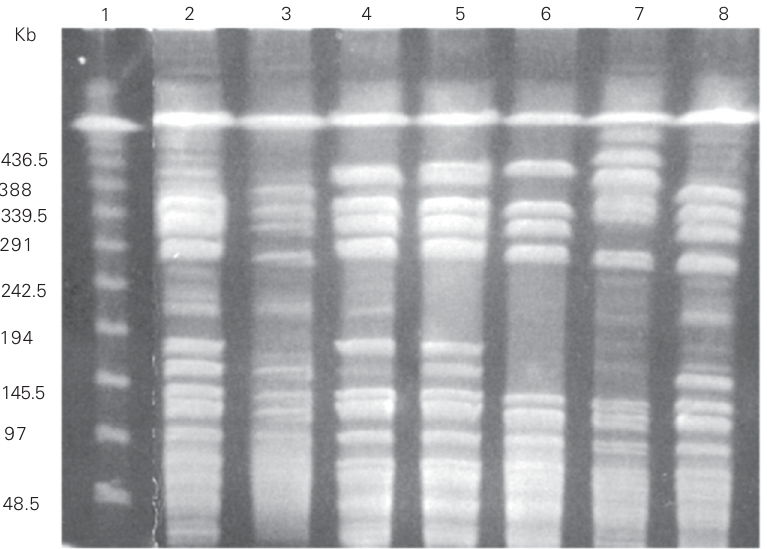
Figure 2. Pulsed-field gel electrophoresis profiles of genomic DNA from methicillin- resistant Staphylococcus aureus (MRSA) strains isolated from patients with hospital infection from May 1995 to August 2001 (period II). Lane 1 : Molecular weight marker ( λ ladder); lanes 3 , 4, and 5 : MRSA profile closely related to the endemic strain; lanes 2 , 7, and 8 : MRSA profile possibly related to the endemic strain; lane 6 , profile A, endemic